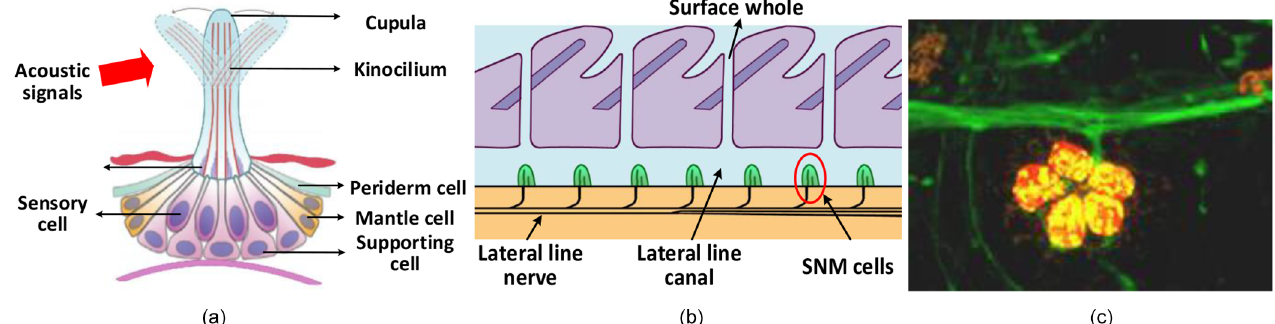
Fig. 3. (a) Four hair cells occur at the center of a schematic depiction of a single SN, modi fi ed after Ref. [11]; (b) Schematic diagram of fi sh lateral line system; (c) The SEM image of the blind cave fi sh lateral line neuromast: a neuromast consists of fi ve adjacent sensory cells (yellow) and a lateral nerve (green).